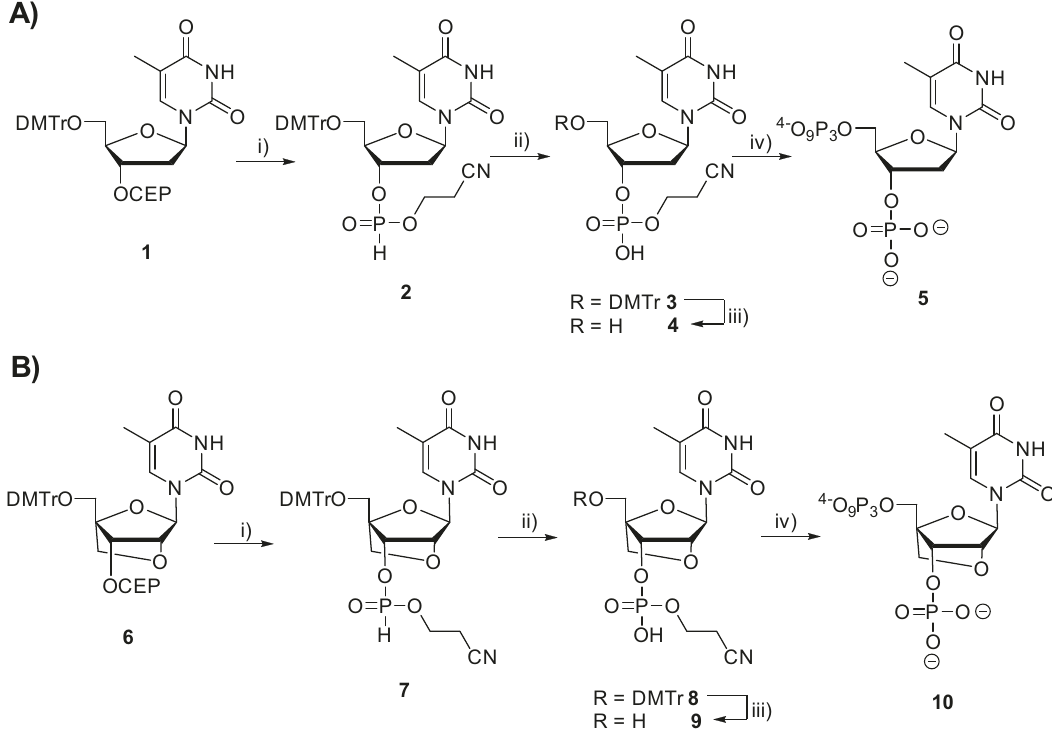
Fig. 2 Synthesis of 3 ′ -phosphate-dTTP 5 and 3 ′ -phosphate-LNA-TTP 10. A Synthetic scheme for the synthesis of nucleotide 5 and ( B ) synthetic pathway leading to nucleotide 10 . Reagents and conditions: (i) ETT, CH 3 CN, H 2 O (9:1), rt, 10 min, quantitative for both 2 and 7 ; (ii) I 2 , pyridine, H 2 O (9:1), rt, 60 min, quantitative for both 3 and 8 ; iii) TFA, DCM, rt, 60 min, 4 (84%), 9 (97%); iv) 2-chloro-1,3,2-benzodioxaphosphorin-4-one, pyridine, dioxane, rt, 45 min;